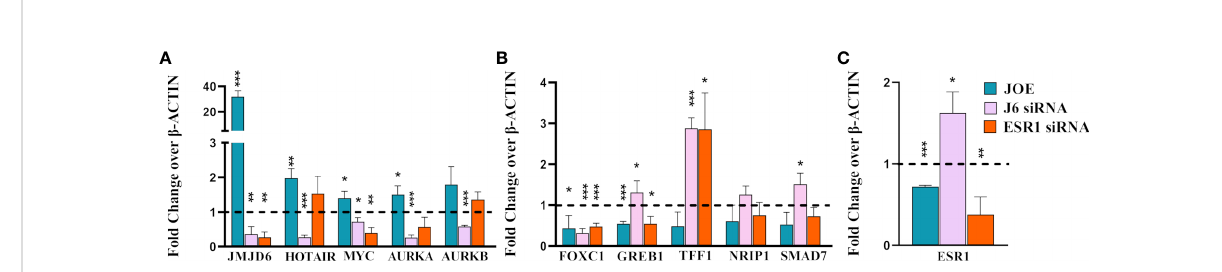
FIGURE 2 Realtime PCR analysis of representative genes in JOE, J6 siRNA and ESR1 siRNA treated MCF7 cells. (A) JMJD6 and JMJD6 regulated genes (B) ER regulated genes (C) ESR1. Vector and Scrambled siRNA treated samples were used as respective controls and values were normalized to 1 (shown as a dotted line). *p ≤ 0.05, **p ≤ 0.01, and ***p ≤